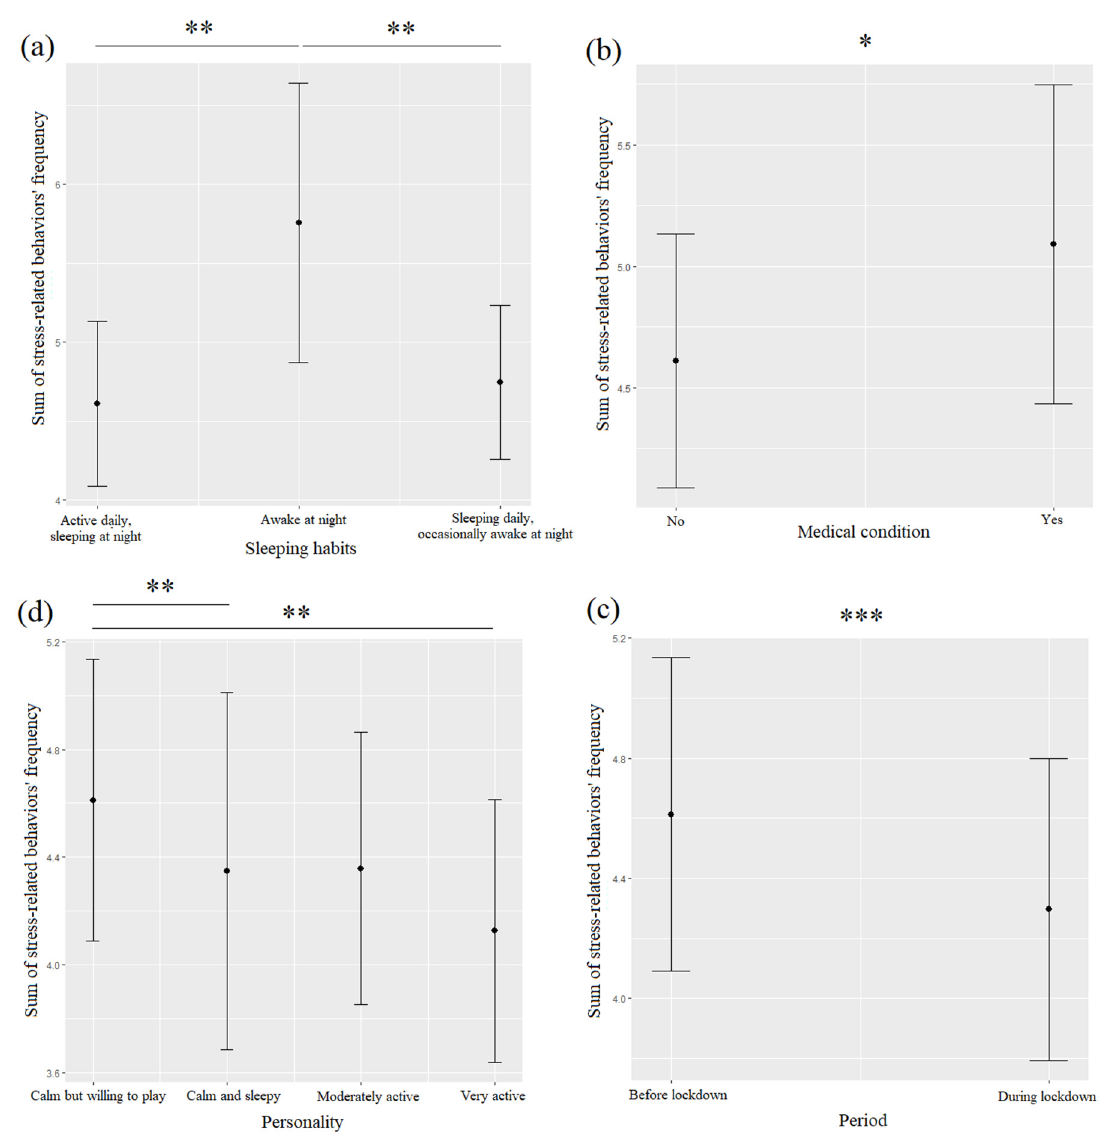
Figure 2. Means and 95% confidence intervals of dogs’ stress-related behaviors’ frequency depending on dogs’ sleeping habits ( a ), medical condition ( b ), personality ( c ), and the period ( d ) extracted from linear mixed-effect models (LMMs). *: p < 0.05; **: p < 0.01; ***: p < 0.001, Wald chi-squared tests with Bonferroni correction.